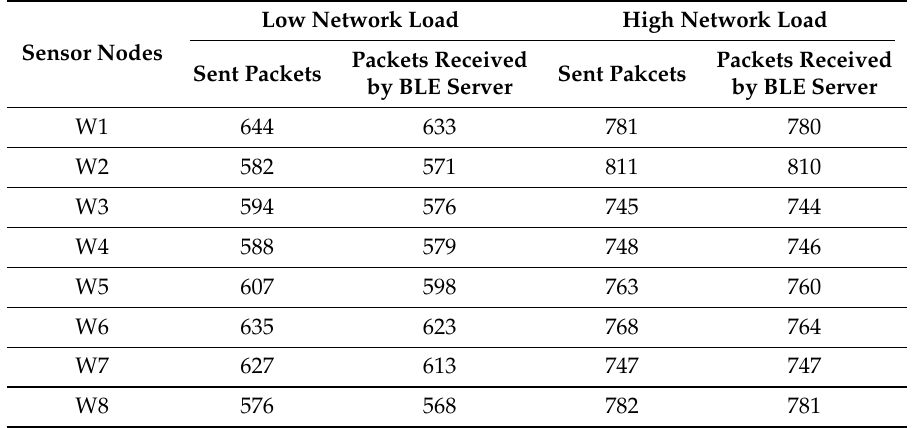
Table 8. Number of packets sent by each sensor node and received by BLE server, for each Waspmote device configuration in Individual Mesh with CSR devices retransmit each packet three times.